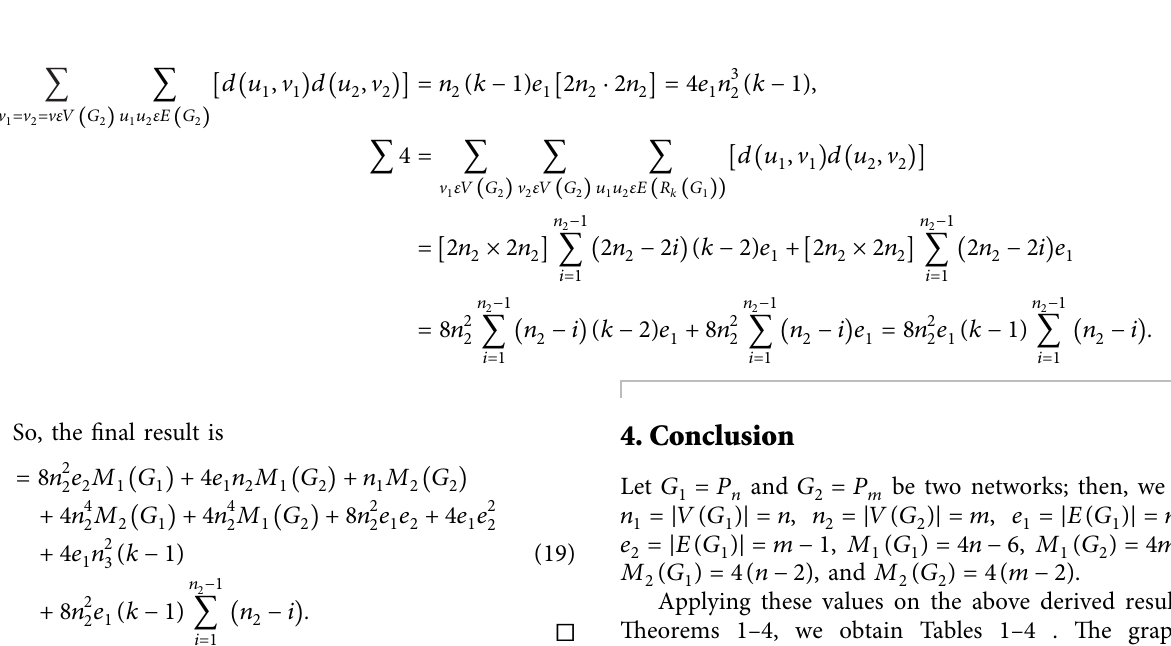
Table 1: Numerical comparison for generalized network G ( P